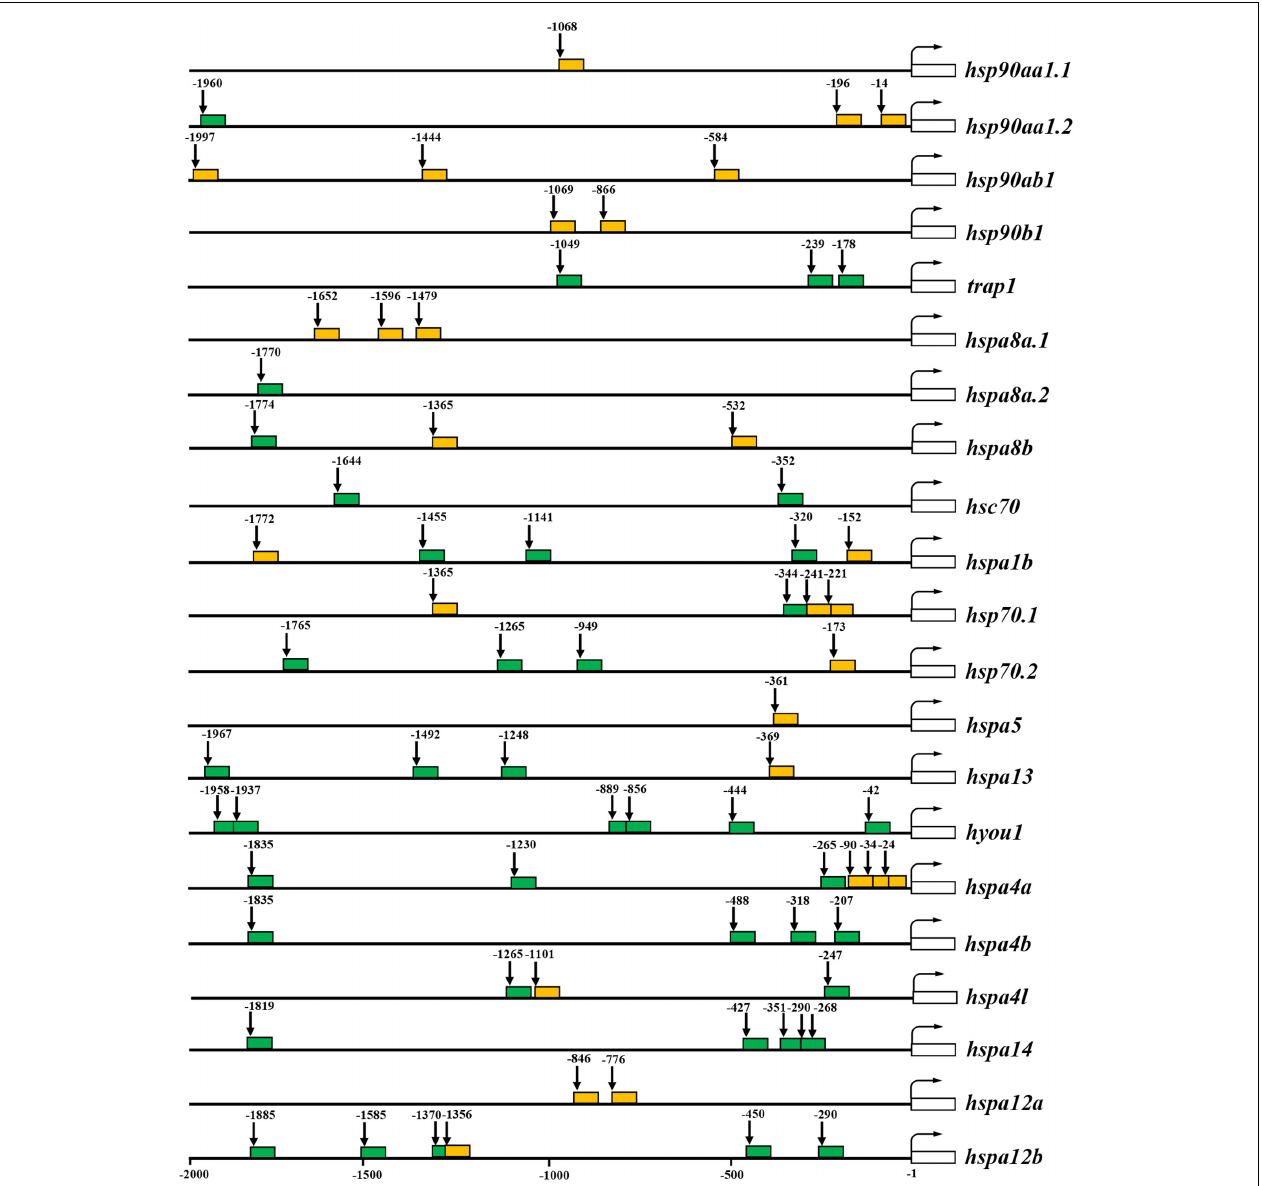
FIGURE 5 | Putative heat shock elements (HSEs) and hypoxia response elements (HREs) in 2 kb upstream regions from the transcription start site (TSS) of HSP90 and HSP70 genes. The predicted HSEs and HREs were shown with orange and green filled boxes, respectively. The numbers indicated spacing (in base pairs) between elements and TSS. The white open box indicates the transcribed sequence. The bent arrow indicates the